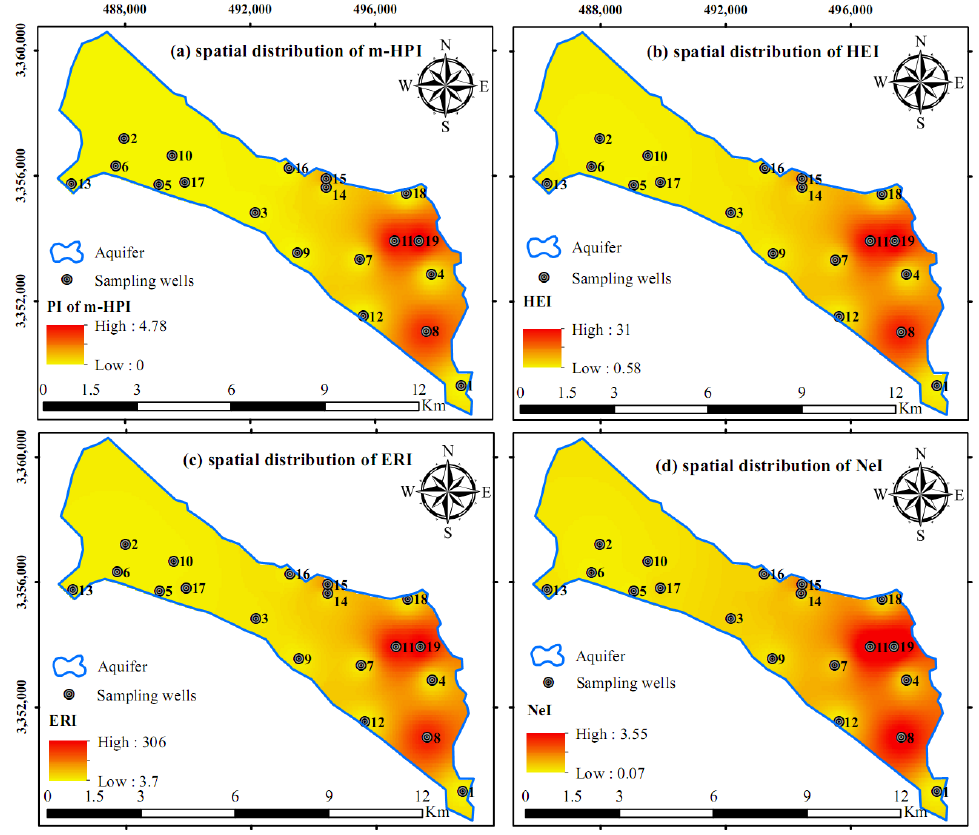
Figure 8. Spatial distribution of heavy metal indices: ( a ) modified heavy metal pollution index (m-HPI); ( b ) heavy metal evaluation index (HEI); ( c ) ecological risks of heavy metals (ERI) ( d ) negative index (NI) in the study area.